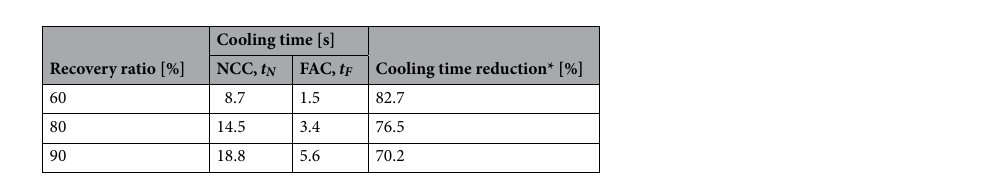
Table 3. Comparison of cooling time for NCC and FAC. *Cooling time reduction = 100